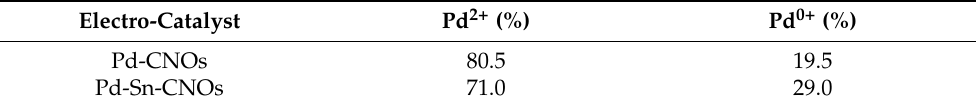
Figure 6. XPS spectra: ( A ) survey spectra for ( B ) Pd 3d for Pd/CNO and Pd-Sn/CNO electro-catalysts. ( C ) Sn 3d for Pd-Sn/CNO electro-catalyst; ( D ) O 1s for CNOs and Pd/CNO and Pd-Sn/CNO electro-catalysts; ( E ) C 1s for CNOs and Pd/CNO and Pd-Sn/CNO electro-catalysts. Table 2. BEs (in eV) and relative percentage areas (in %) of the two components of the Pd 3d core level for CNO